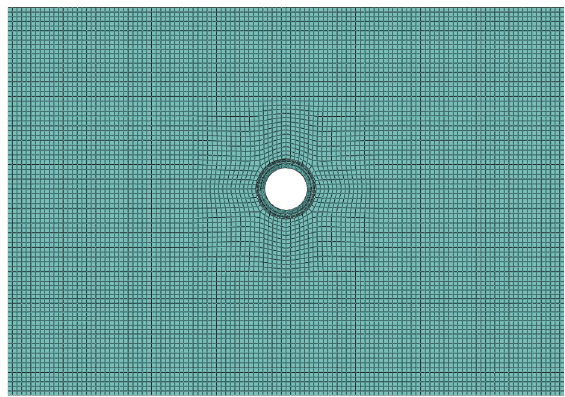
Figure 11: Numerical model of the area around Pile No. 28